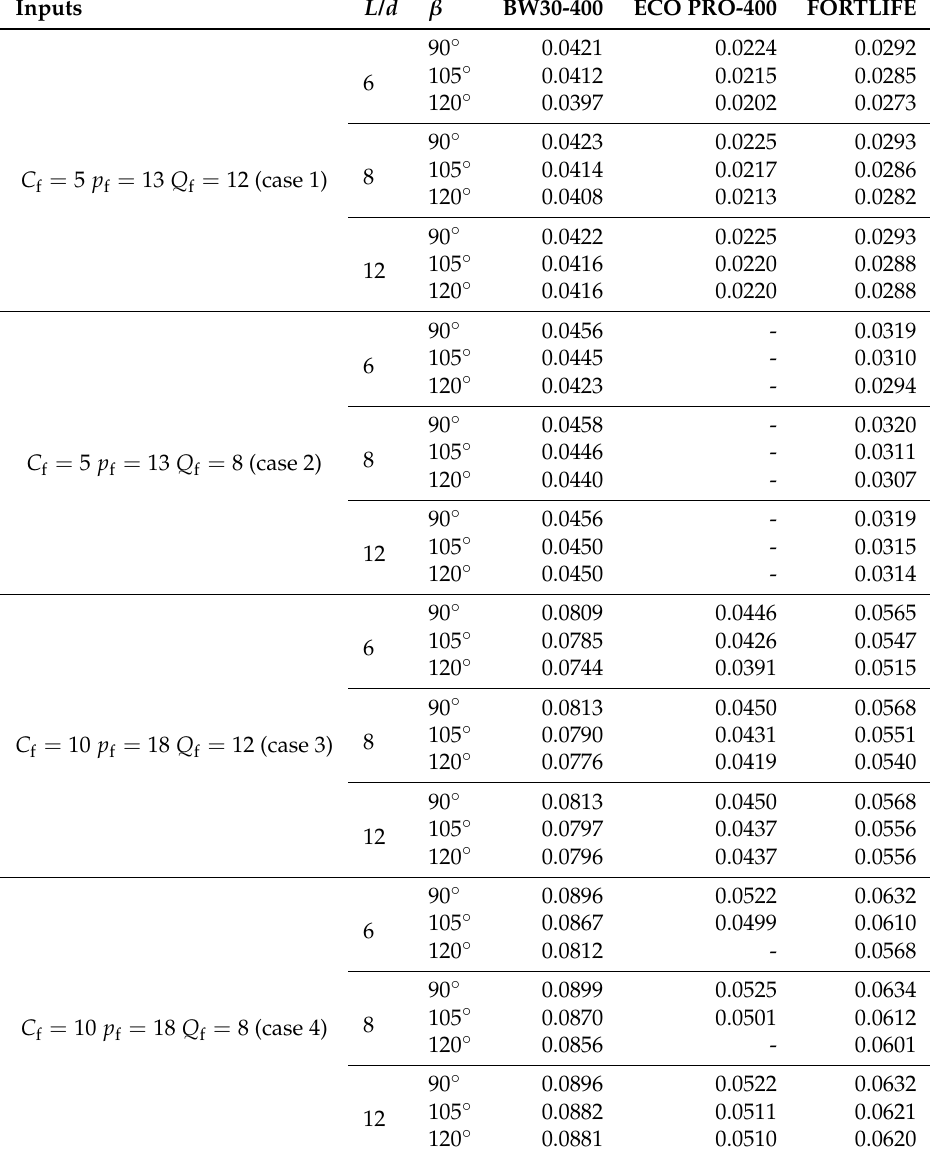
Table 5. C p (g L − 1 ) for the three membranes studied with different spacer geometries.